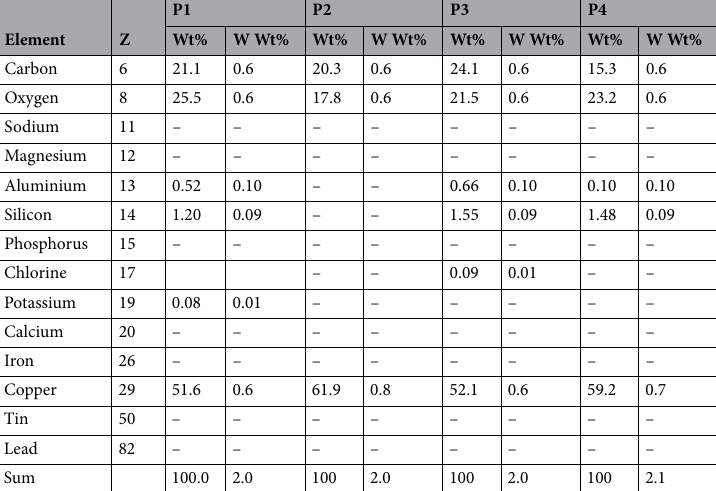
variations of metal alloys. Studies about solid-state electrochemistry of copper and bronzes artefacts showed that the relationship between cuprite and tenorite (i(II) vs. i(I)/i(II)) can help in the discrimination of corrosion compounds formed on the surface 12,15 . Figure 2Sa,b (Supplementary Materials) details the results obtained from the sampling points of the inclusion #2 mapped in Fig. 5a. Most samples showed a high percentage of PbO (2B, 3B, 3A in Fig. 2Sa,b) whereas only 4B was uniquely characterised by copper oxides. Samples 1A and 1B were composed of a mixture of these oxides.